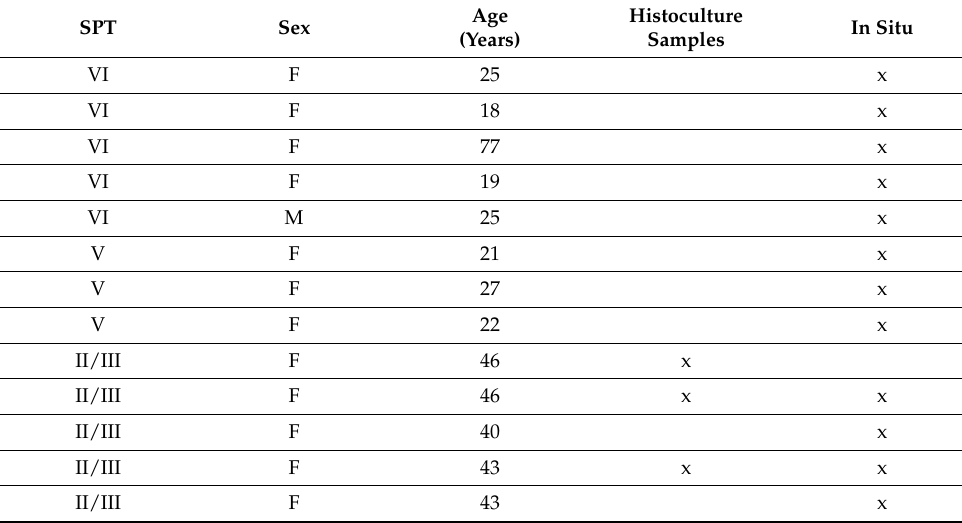
Table 1. Information of human skin samples used for histoculture experiments or for low vs.